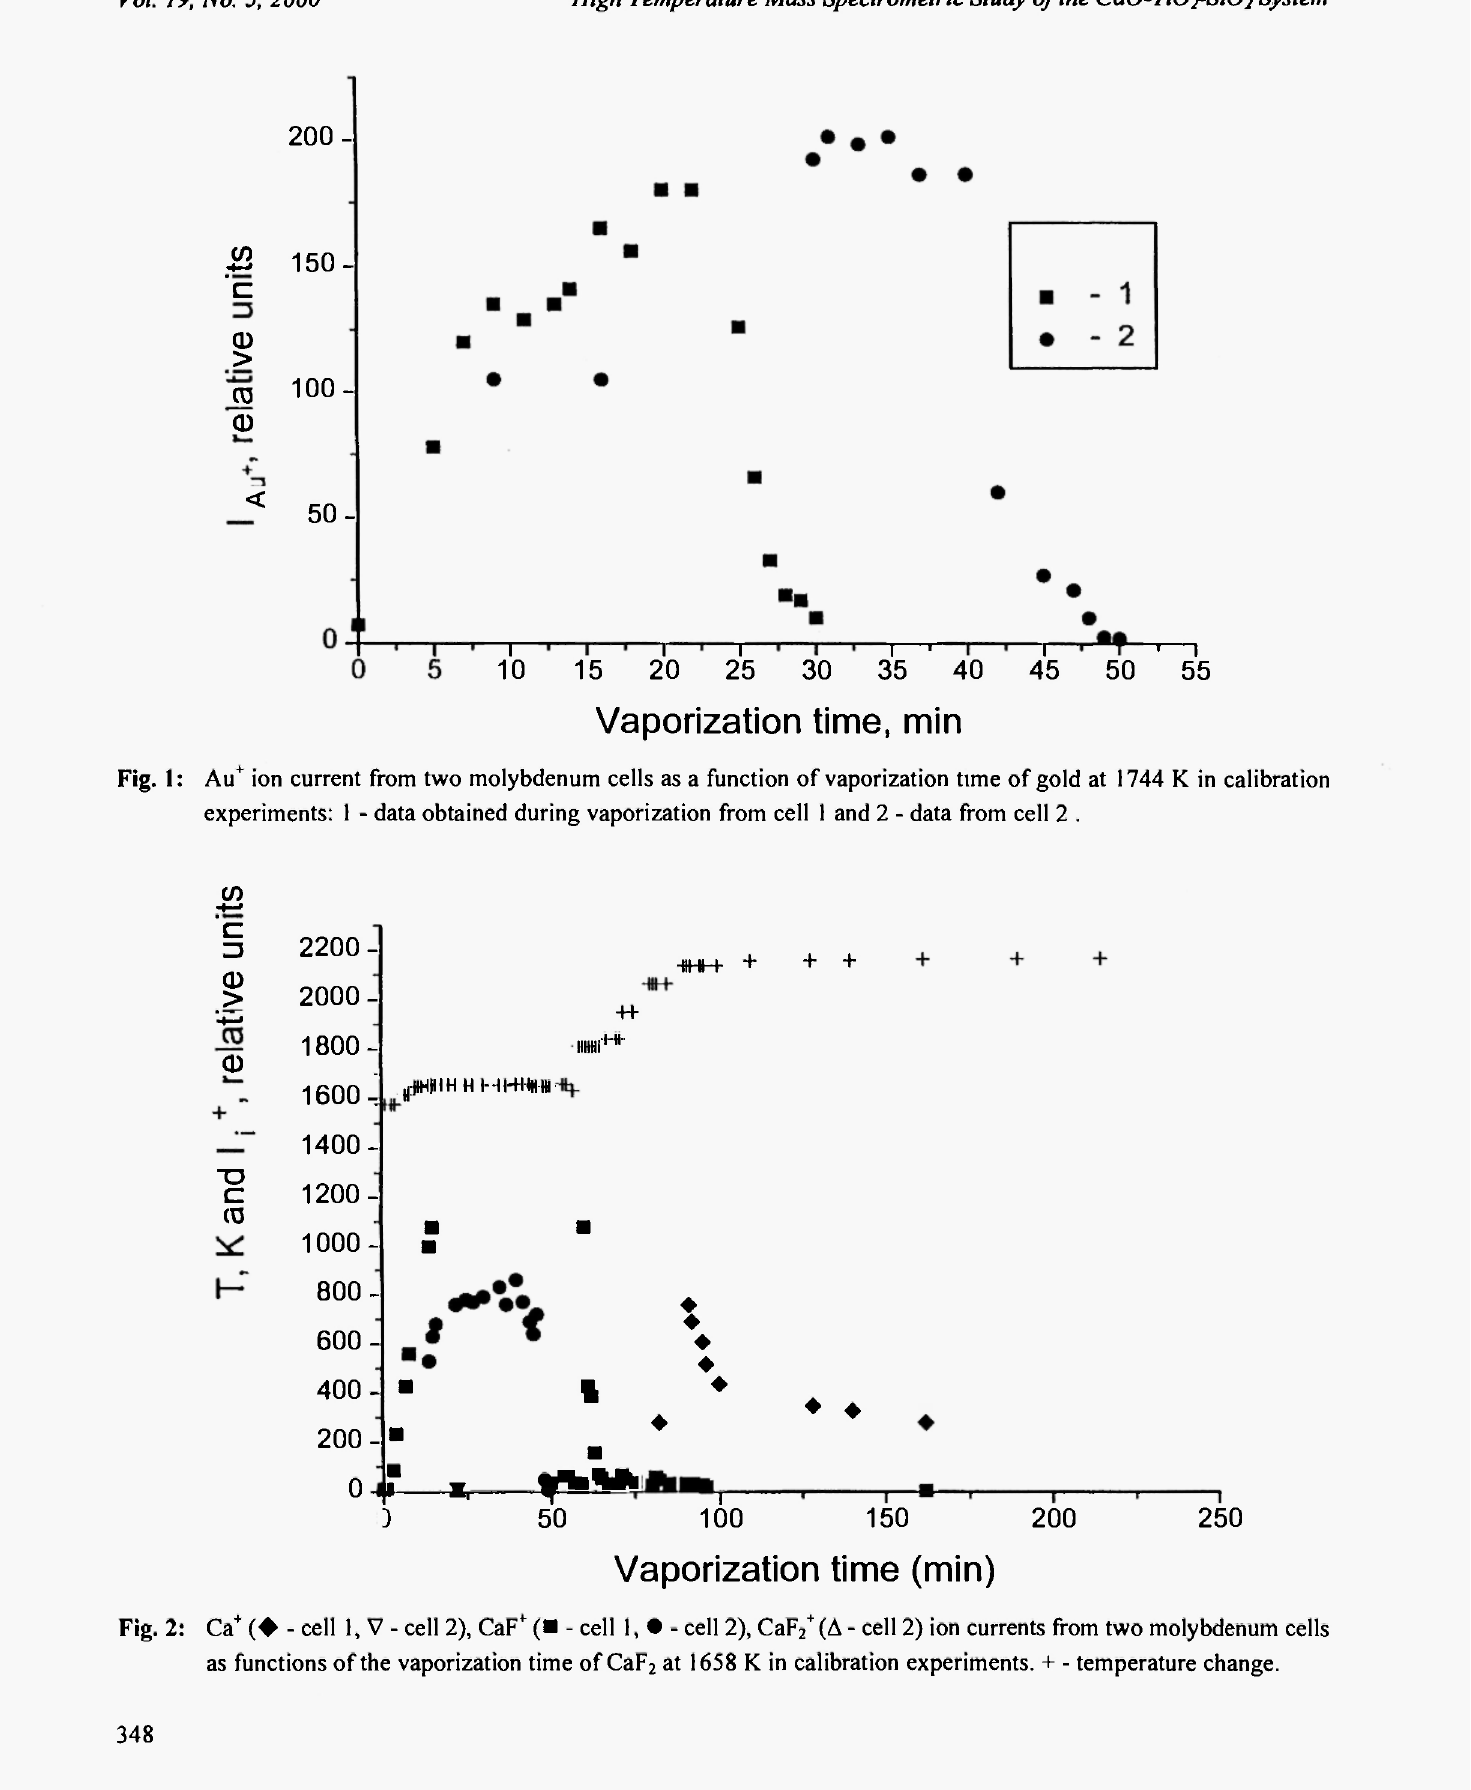
Fig. 2: Ca + (• - cell 1, V - cell 2), CaF + (• - cell 1, · - cell 2), CaF 2 + (Δ - cell 2) ion currents from two molybdenum cells ; functions of the vaporization time of CaF 2 at 1658 Κ in calibration experiments. + - temperature change. as